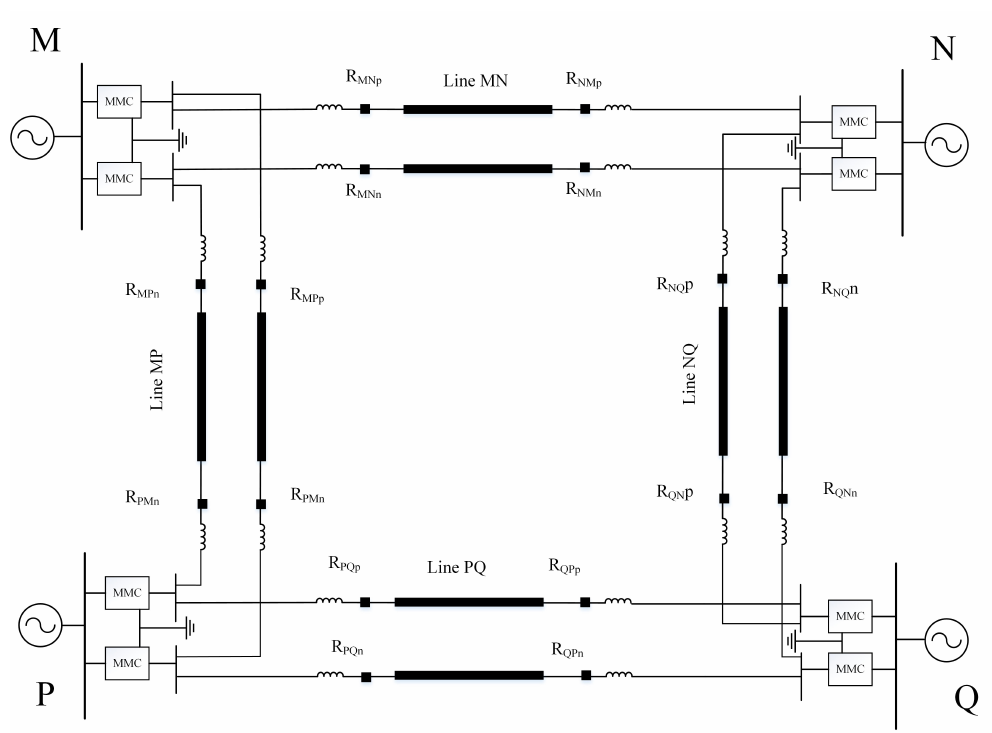
Figure 1. Four terminal MMC-HVDC